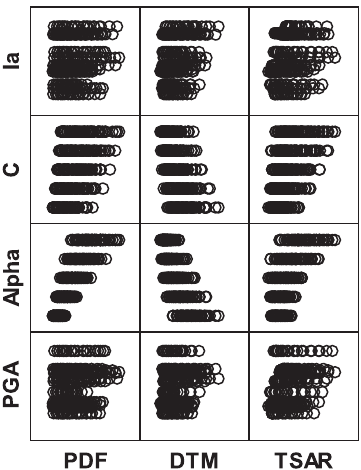
Fig. 7. Matrix scatter plot among three dependent output variables ( P DF , D TM , TSAR) and four independent input variables ( C , a , PGA, I a ) Fig. 8. Definition of the linear regression terms, R